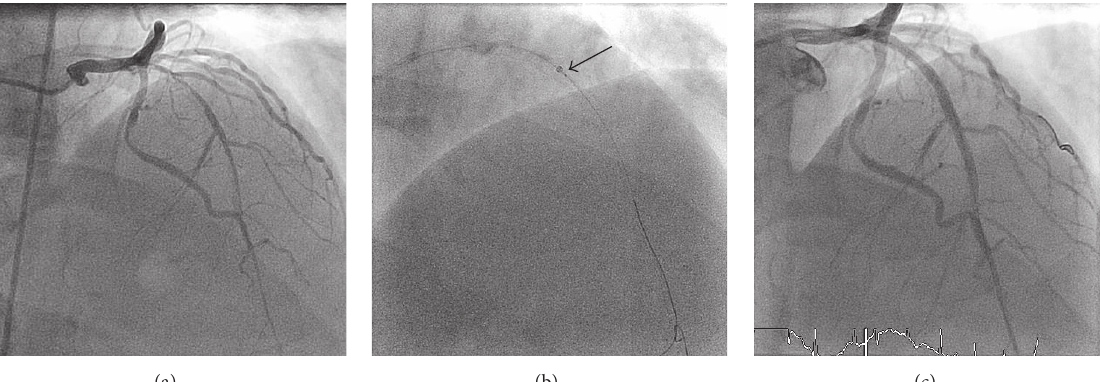
Figure 4: Successful PCI of the LAD using GBAT. (a) Diffusely diseased proximal LAD. (b) GBAT assisted advancement of the GuideLiner passes the proximal stenosis; black arrow indicated the GuideLiner as it passes the lesion with an inflated balloon. (c) Successful PCI to the